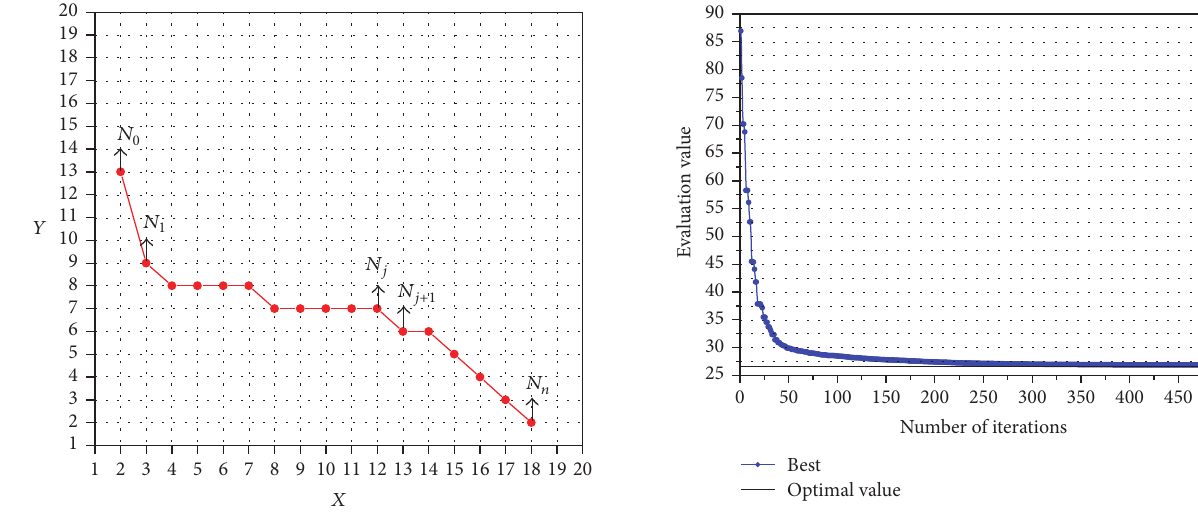
Figure 5: Discretization sketch of pipeline route. Figure 6: Performance of the GA in finding the best solution.